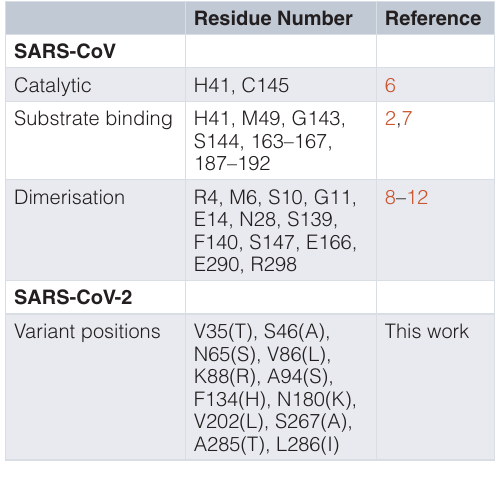
Table 1. Important residues of 3CL pro from SARS- CoV (conserved) and the SARS-CoV-2 variant residues. The residues that play functional roles in SARS-CoV 3CL pro are listed on the top three rows. These are absolutely conserved in the SARS-CoV-2 protein. The variant residues found in the SARS-CoV-2 protein are listed in the bottom row, with the SARS-CoV residues in